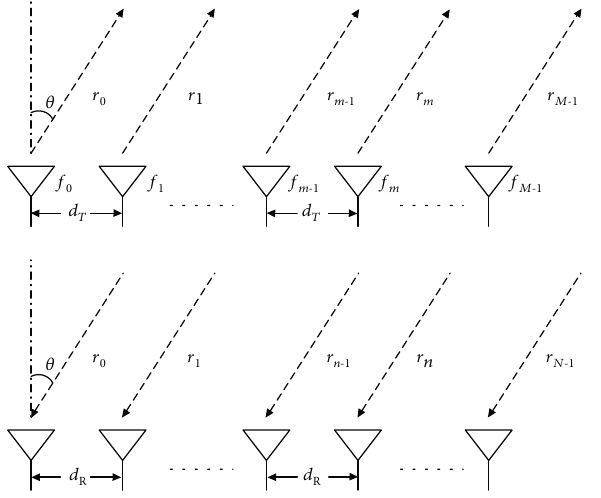
Figure 1: Con fi guration of FDA-MIMO.